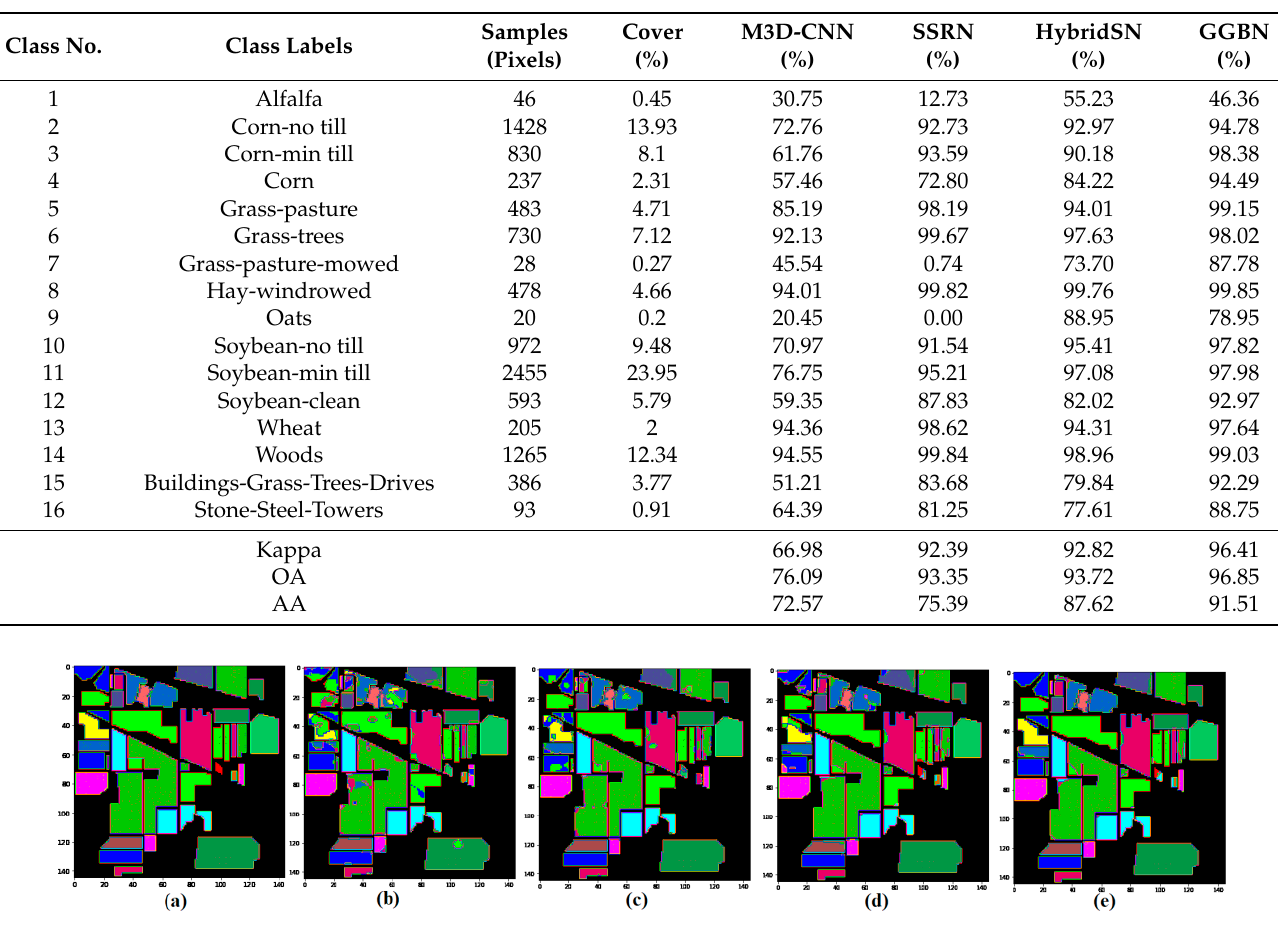
Figure 9. Classification maps of Indian Pines data set: ( a ) Ground truth; ( b ) M3D-CNN; ( c ) SSRN; ( d ) HybridSN; ( e ) GGBN.